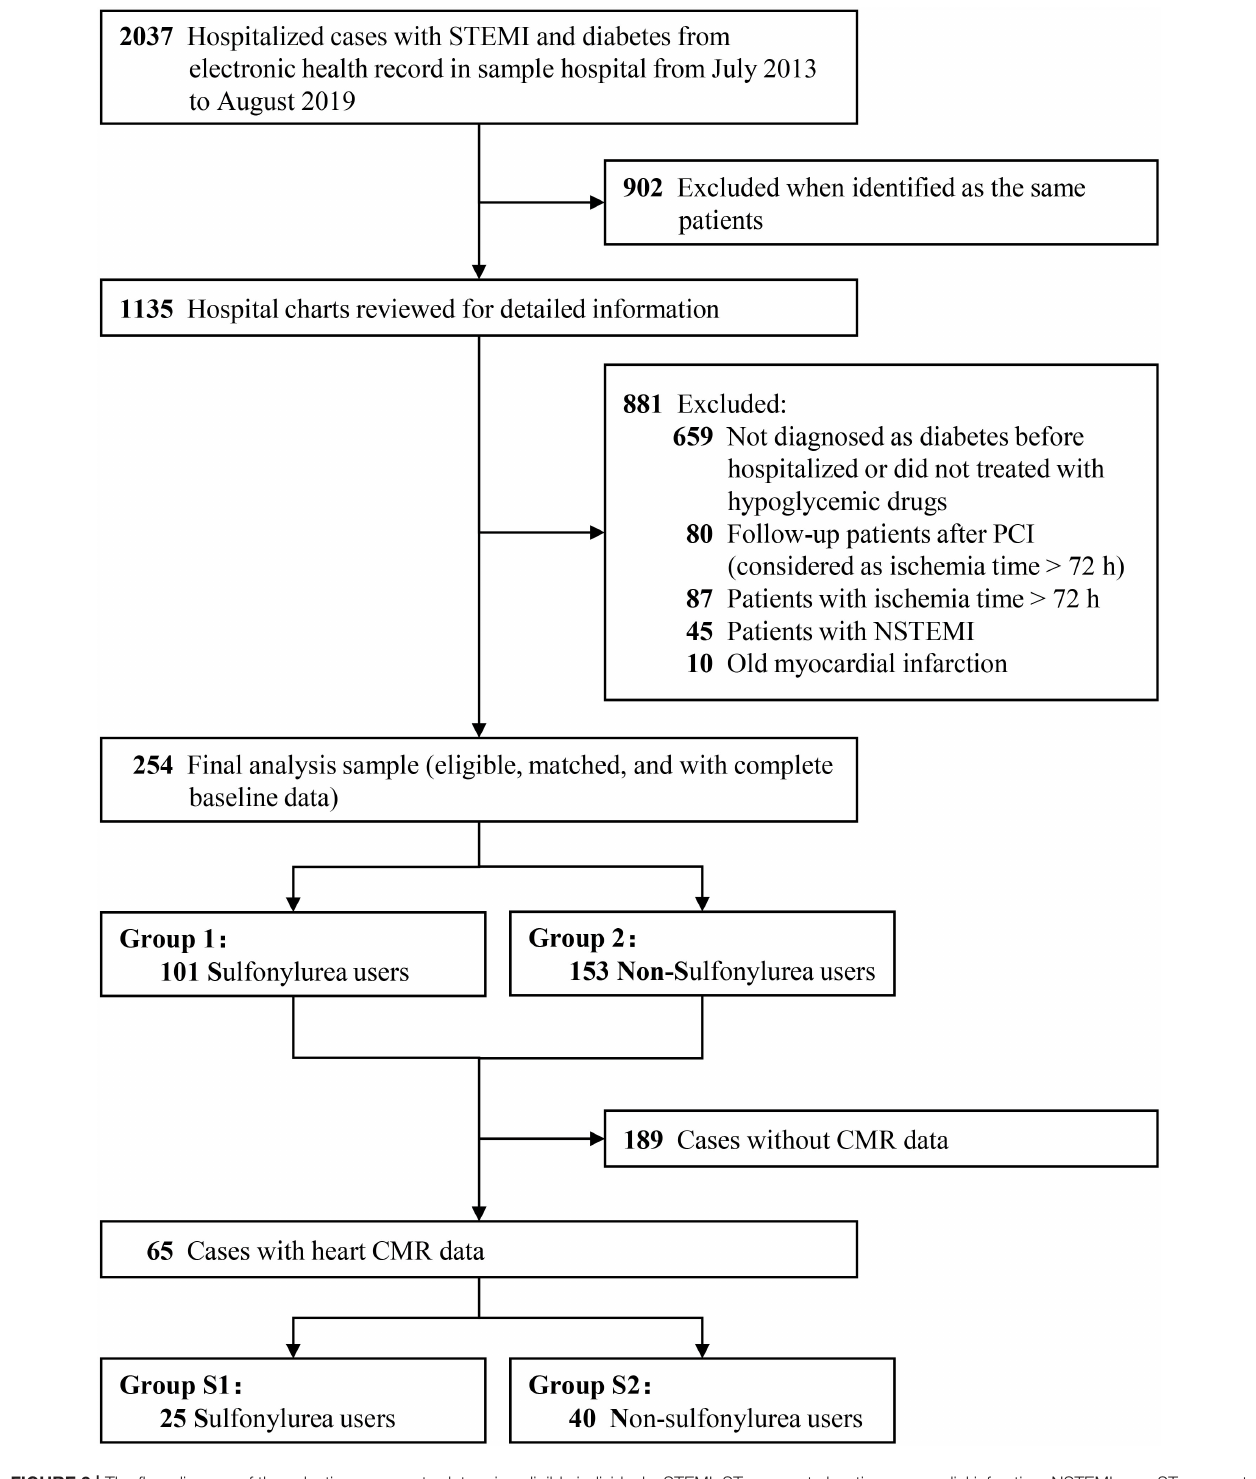
Frontiers in Cardiovascular Medicine |